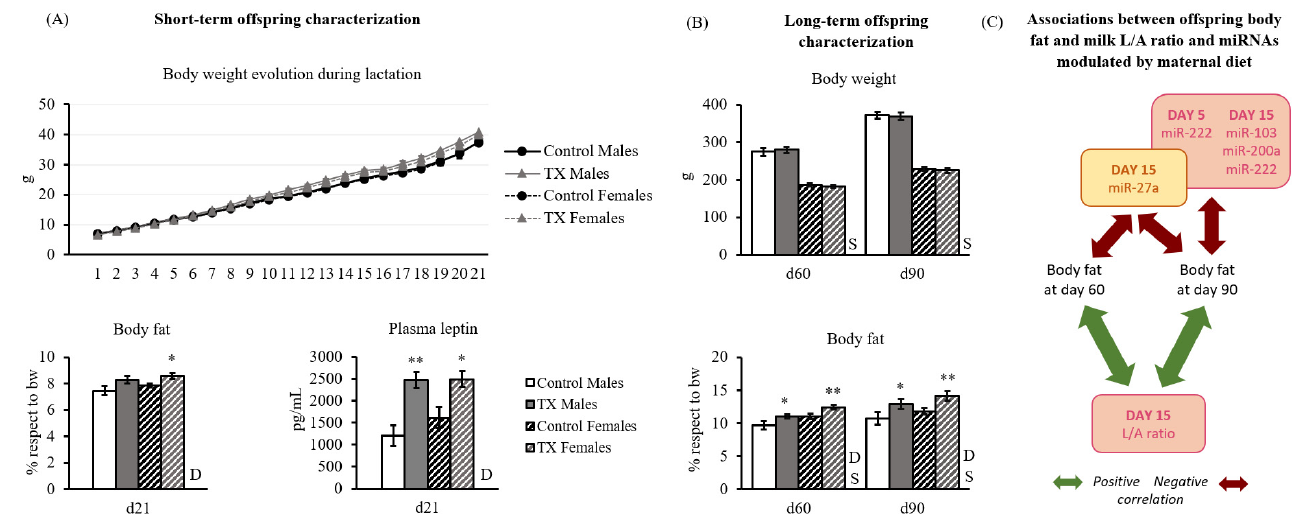
Figure 5. Offspring characterization in the short term ( A ) and long term ( B ). ( A ) Body weight evolution was tracked throughout the lactation period, and on day 21, body fat and plasma leptin were measured ( n ≈ 35). ( B ) Body weight and body fat were measured at days 60 and 90 of age ( n = 16). ( C ) Schematic representation of the associations observed between offspring body fat mass and milk L/A ratio and the miRNAs modulated by maternal diet. In yellow is the variable exclusively modulated by maternal diet, and in pink, those that were modulated by both maternal diet and day of lactation. Positive correlations are represented with green arrows, whereas the negatives are in red. Data are mean ± SEM. Statistics: A two-way ANOVA was carried out to study the effect of maternal diet and sex: D, the effect of maternal TX diet; S, sex effect. Single comparisons between groups were performed by Student’s t -test: *, different from their respective control. To study the associations between offspring body fat and milk L/A and diet-modulated miRNAs, Spearman correlation analysis was performed. Threshold significance was set at p ≤ 0.05 for all tests (**, p ≤ 0.00). dex at the age of 90 days are shown in Figure 6. Notably, the HOMA index was signifi-